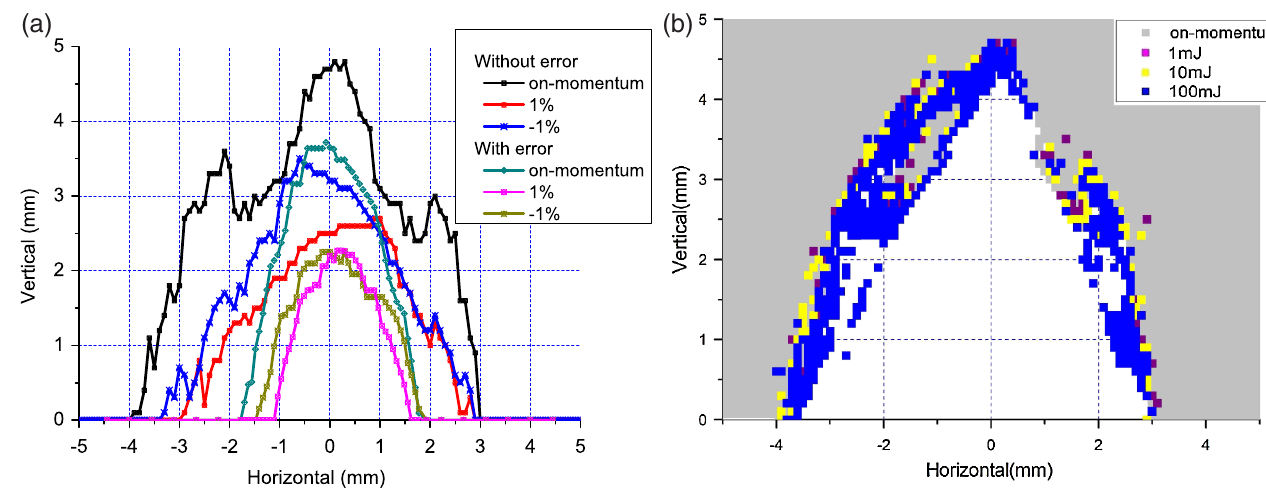
FIG. 3. (Color) Dynamic apertures for (a) various momentum deviations, and (b) various laser energies. The on-momentum DA without errors is about 3 mm. We tracked the particles for 50 000 turns with misalignments, tilts, and field errors included for various momentum deviations. The off-momentum DA at momentum deviation (cid:5) 1% is about 1 mm. Even for the laser energy of 100 mJ, the DA is large enough for the stable motion of the electron. The dynamic aperture tracking including CS has shown that the lattice is robust enough for this stochastic